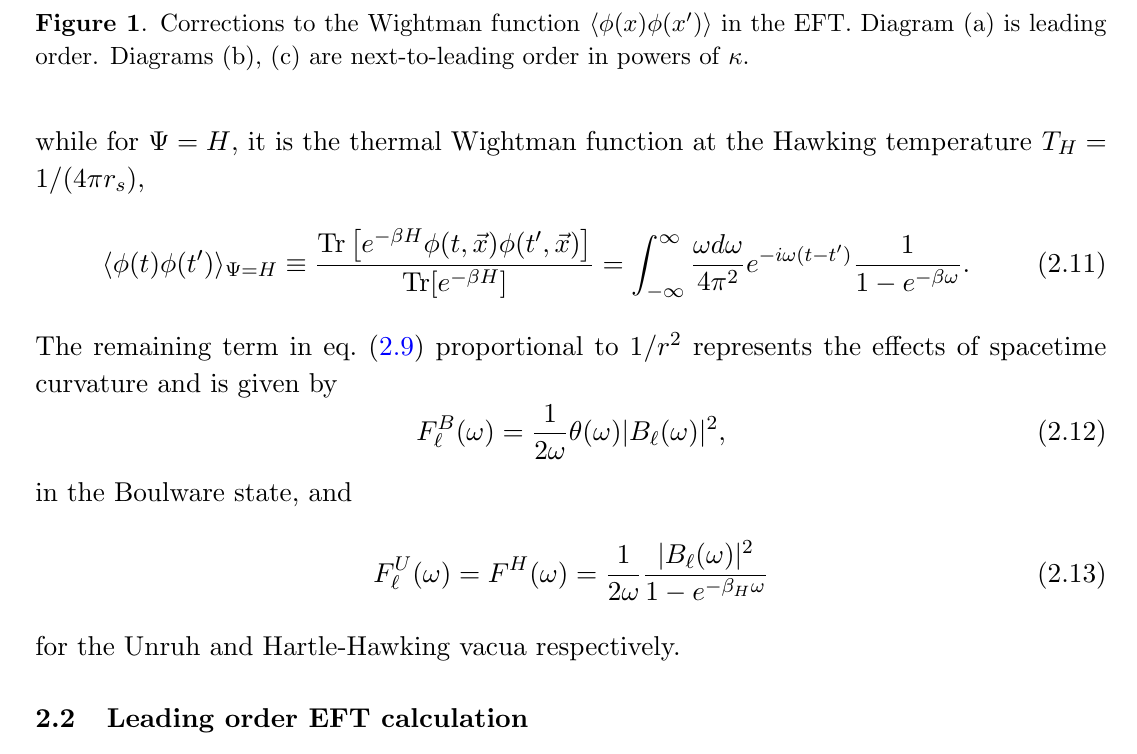
(cid:30) ( x ) (cid:30) ( x 0 ) in the EFT. Diagram (a) is leading h i